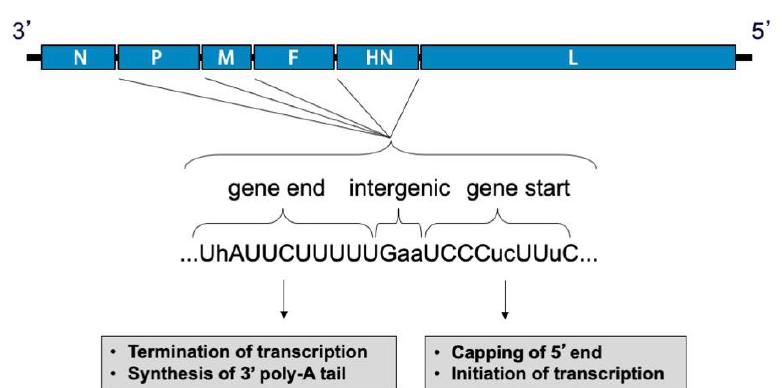
Figure 3. Intergenic junctions of SeV. Upstream of each gene is a gene start sequence that directs initiation of transcription and capping of the 5′ end of the transcript. Downstream of each gene is a gene end sequence that directs termination of transcription and synthesis of a 3′ poly-A tail. A trinucleotide sequence separates gene end from gene start between the genes. Differences in gene start sequences modulate the level of polymerase continuation of transcription versus termination.